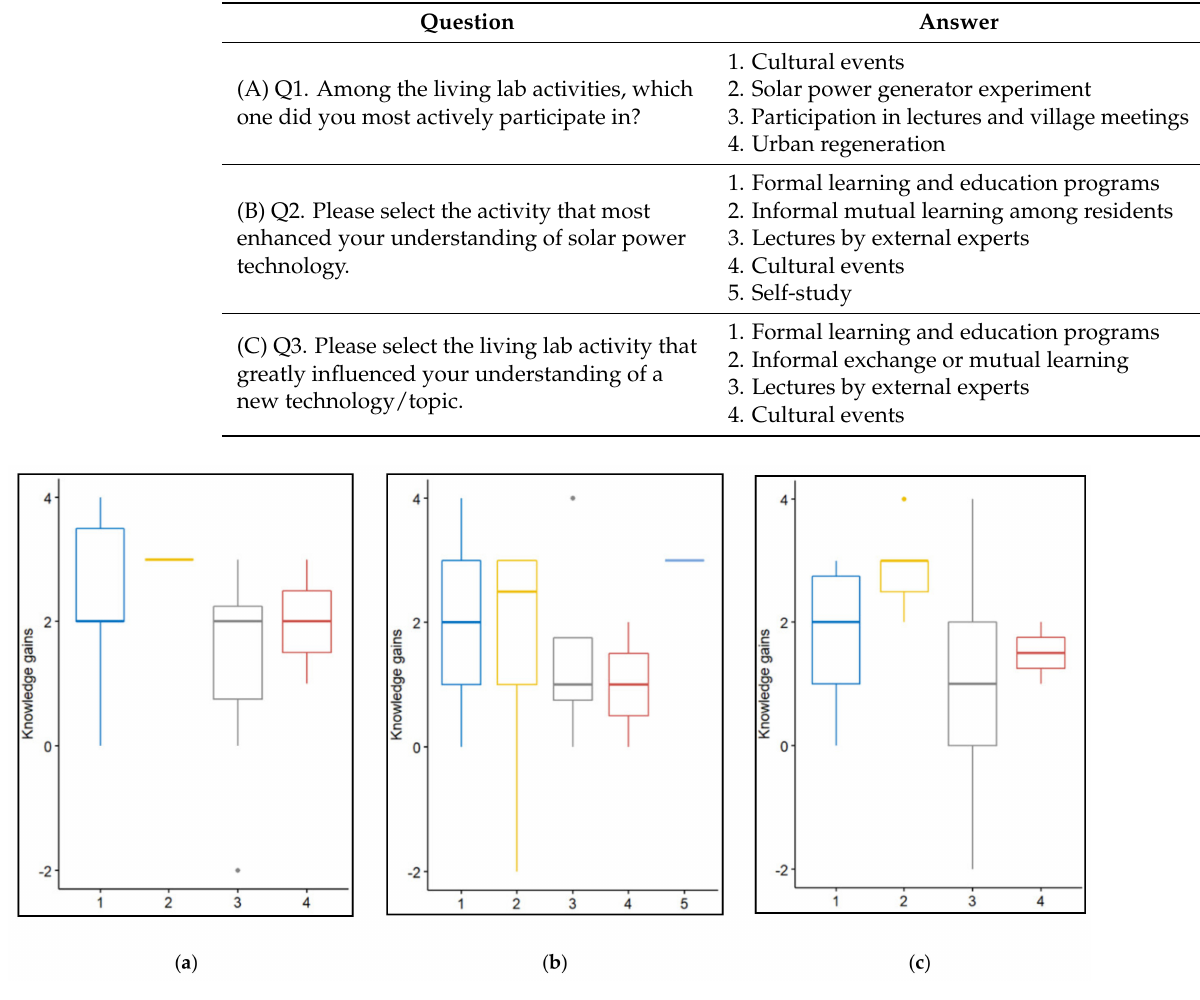
Figure 9. Two-way ANOVA tests for ( a ) Q1, ( b ) Q2, and ( c )